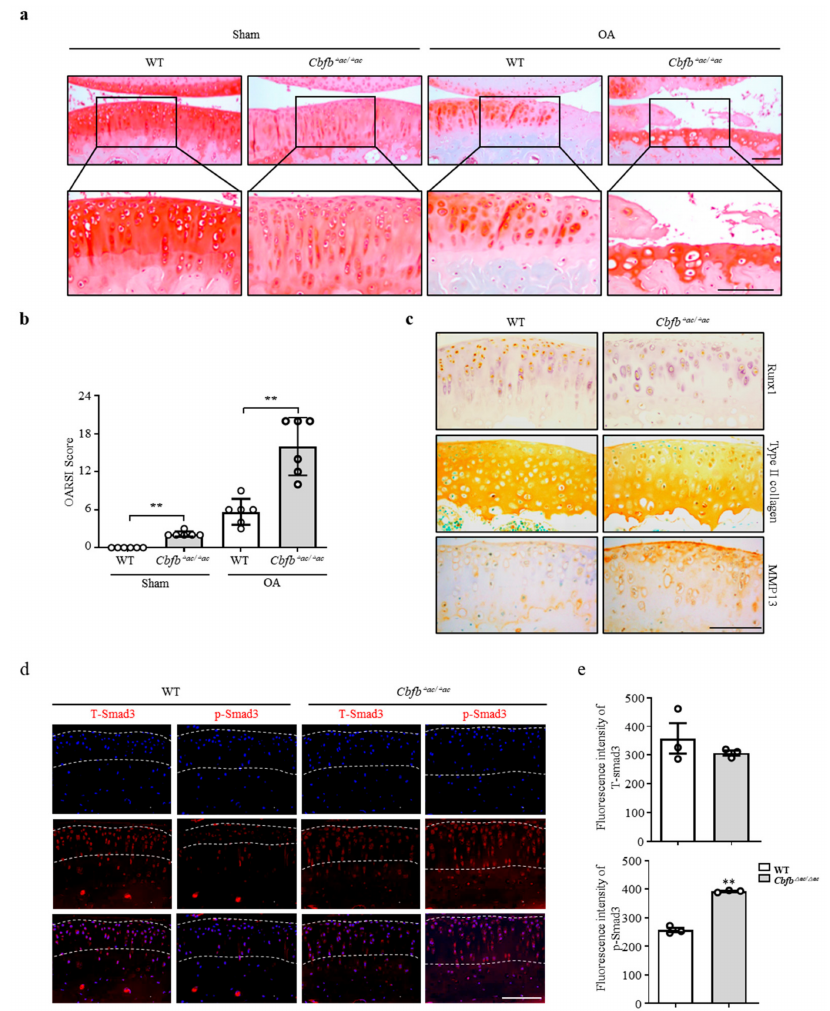
Figure 3. Deletion of Cbfb in articular chondrocytes accelerated OA pathogenesis progression. ( a ) Articular cartilage was severely destroyed in Cbf β (cid:52) ac/ (cid:52) ac mice; the destruction was assessed using Safranin O staining 8 weeks after DMM surgery. ( b ) The severity of OA was analyzed accord- ing to OARSI guidelines. ** p < 0.01 ( n = 6). Scale bars, 100 µ m. ( c ) Immunohistochemical staining was performed on paraffin sections using anti-Runx1, -Col2 α 1, and -Mmp13 antibodies. ( d ) Expression of total Smad3 (T-Smad, left panels) and p-Smad3 (right panels) in articular cartilage was assessed using immunofluorescence staining in WT and Cbf β (cid:52) ac/ (cid:52) ac 20-week-old mice. ( e ) The T-Smad3 and p-Smad3 fluorescence intensities were analyzed with the Leica fluorescence analysis program. ** p < 0.01 WT ( n = 3). Scale bars, 100 µ